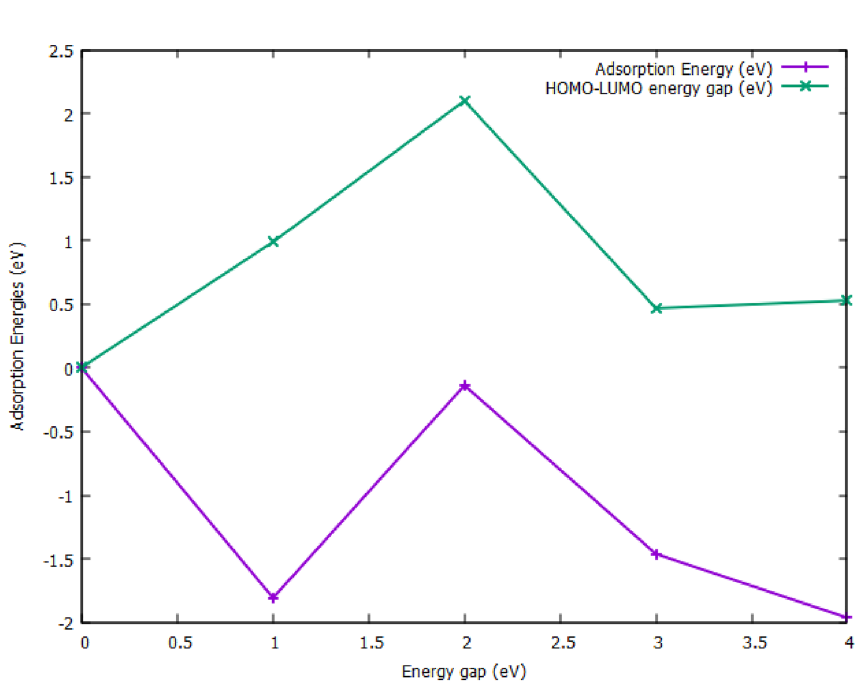
Figure 3. Graph of adsorption energy cum HOMO–LUMO energy gap of the studied engineered Fullerene- H system showing the relationship between E ads and E HOMO–LUMO